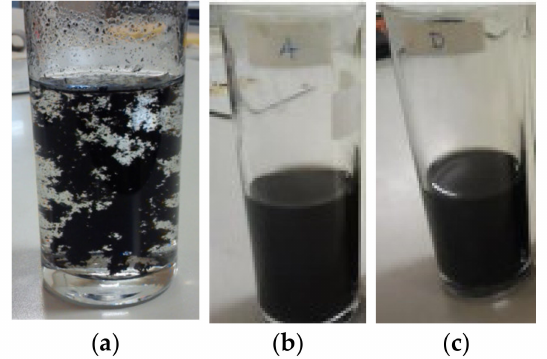
Figure 7. Photographs of MWCNT suspensions immediately after ultrasonication for a MWCNT concentration of 0.01%: ( a ) sample without surfactant, ( b ) sample with Glycerox at concentration of 0.5% and ( c ) sample with Amber 4001 at concentration of